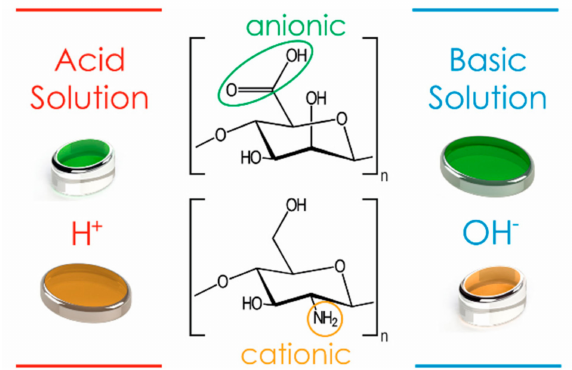
Figure 8. Schematics showing the swelling / deswelling behavior of pH-responsive hydrogels in acid and basic solutions, depending on their ionic nature, anionic or cationic. (Original figure from the authors).